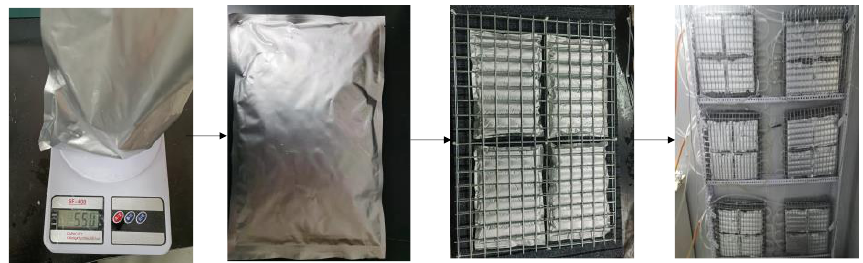
Figure 2. PCM wall production process.